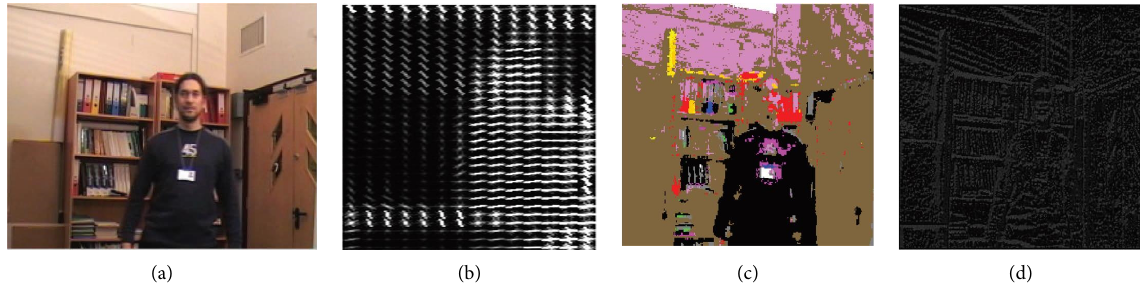
Figure 3: Visualization results of the three features on the Man sequence. (a) original image. (b) HOG. (c) CN. (d)